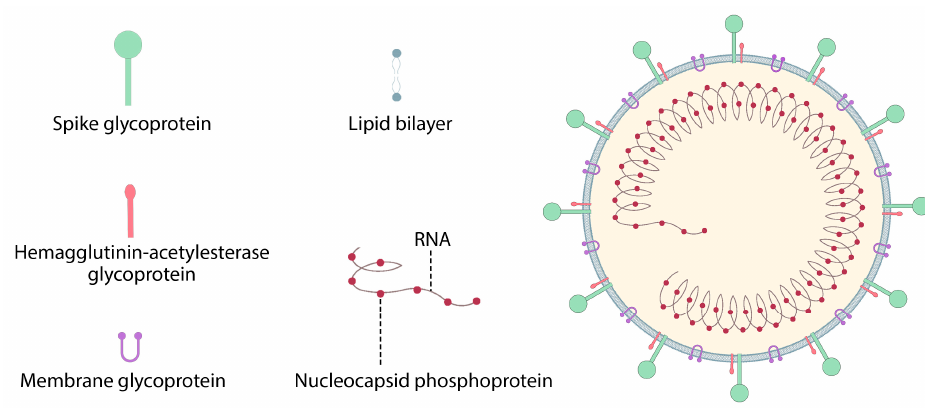
Figure 9. Structure of coronavirus.